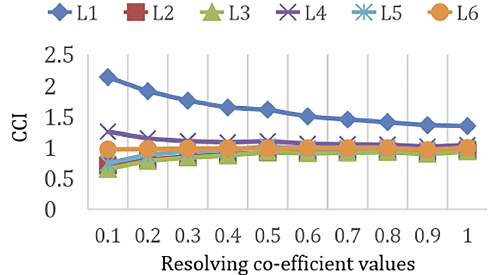
Figure 3. Sensitivity analysis of CC i values for each